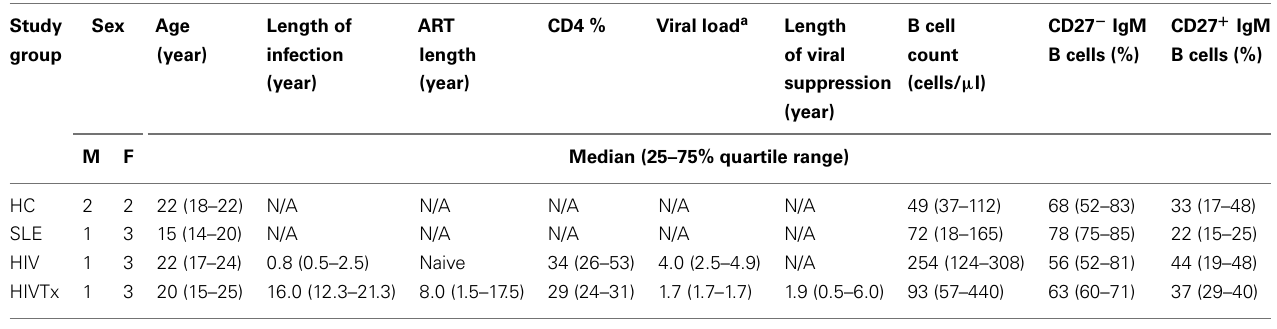
Table 1 | Demographic characterization of study